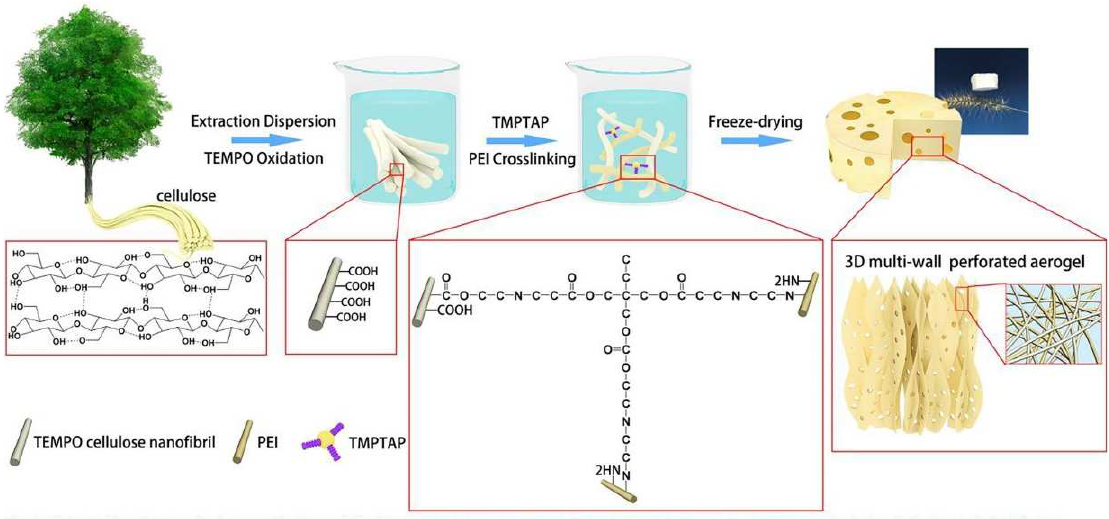
Figure 8. Schematic illustration and formation mechanism of crosslinked TO-CTP aerogel with 3D multi-wall perforated structure. Adapted with permission from [88]. Copyright 2019 Elsevier.